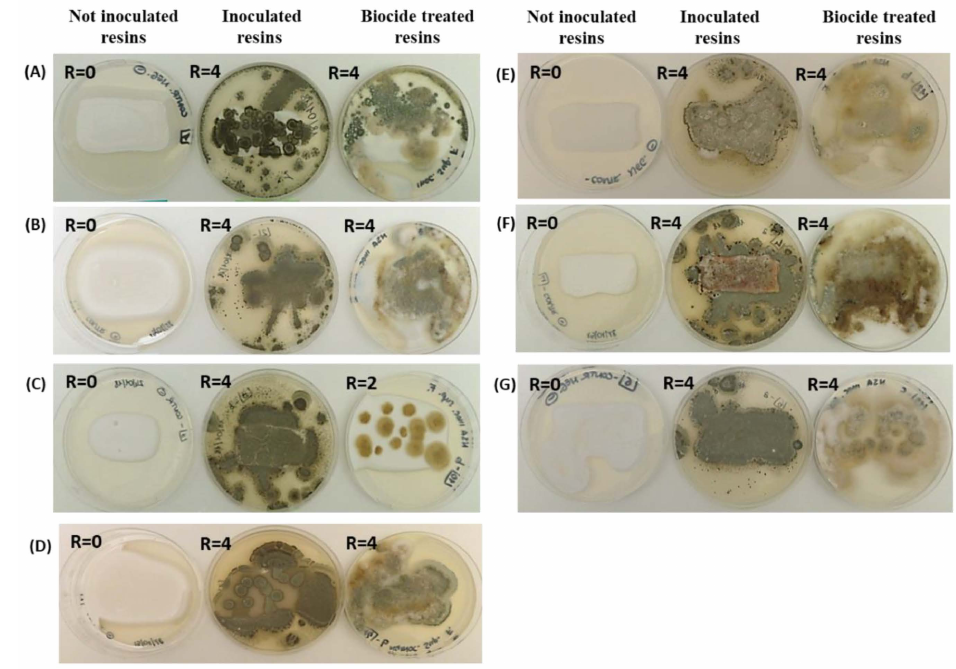
Figure 1. Representative visual observations of the fungal growth after 7 days of incubation on the surfaces of seven different polymers: ( A ) AC 012, ( B ) AC 013, ( C ) PU H6, ( D ) PU MW2, ( E ) PUGS, ( F ) ACP1, ( G ) AC 32. For each sample, non-inoculated control resins, resins inoculated with fungi, and resins treated with biocide and inoculated with fungi were considered. The R rating values (from 0 to 4) are also indicated.